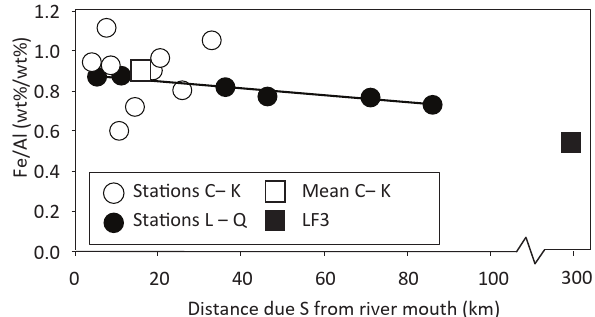
Figure 9. Fe / Al weight ratios for surface sediment samples along the Mustionjoki transect (0–2cm; Stations C–K) and Paimionjoki transect (0–1cm; StationsL–Q), plotted against distance from the respective river mouth. Stations A and B have been removed from the analysis due to the influence of industrial Fe pollution (see Sect. 5.4). A linear regression line is shown for the Paimionjoki transect. Typical values from a site on the Baltic Sea shelves (LF3, Eastern Gotland basin Fe / Al = 0.5–0.6, Lenz et al., 2015) are shown for comparison. LF3 is given an arbitrary distance of 300km from the river systems of the southern coast of Finland, although Fe at this site may be sourced from more proximal